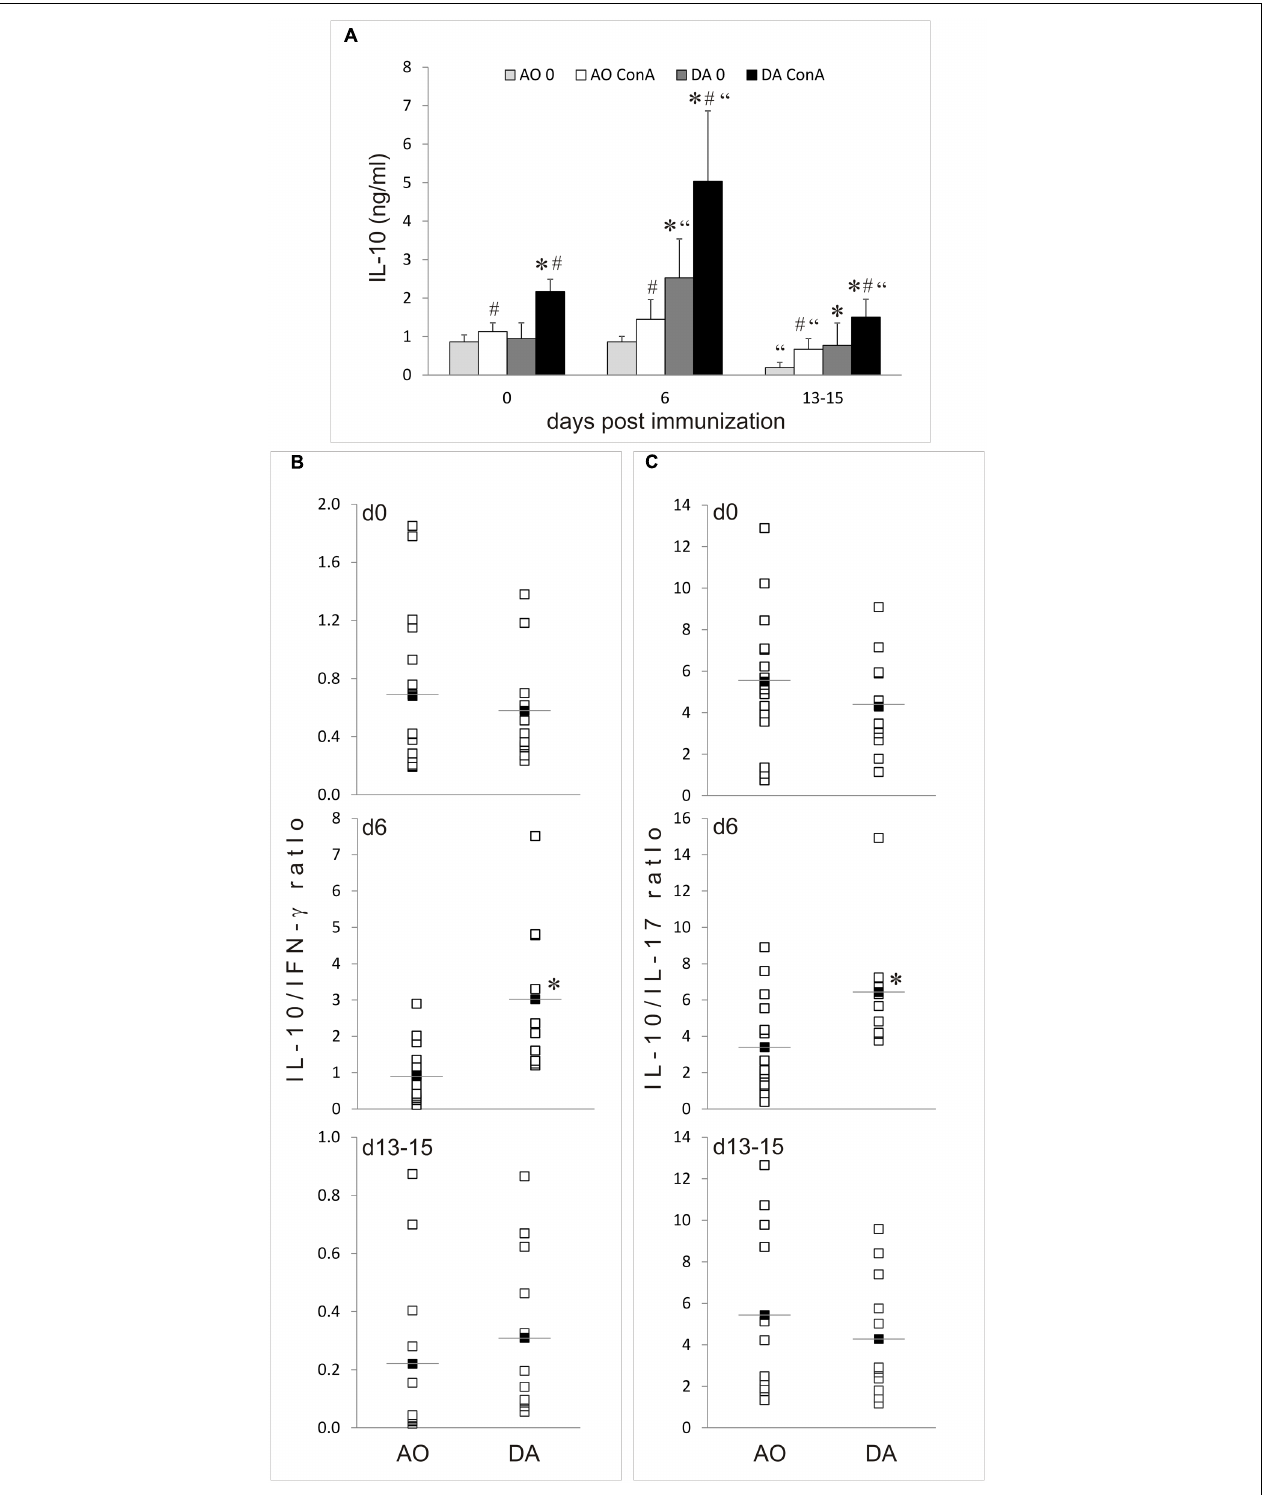
FIGURE 4 | IL-10 production in MLNC. MLNC were isolated from non-immunized (0 d.p.i.) AO and DA rats or from immunized rats at 6 d.p.i and 13–15 d.p.i. Cytokine levels were measured in supernatants of 24 h cultures of un-stimulated (0) or ConA-stimulated (ConA) cells. IL-10 levels are presented as mean ± SD from at least six rats per group (A) . Ratios of IL-10 levels to IFN- γ (B) or to IL-17 (C) levels determined in ConA-stimulated cultures are presented as individual values (white squares) and as mean (black squares with line). ∗ p < 0.05 AO vs. DA; “ p < 0.05 to 0 d.p.i. of the same strain; # p < 0.05 0 vs. ConA.